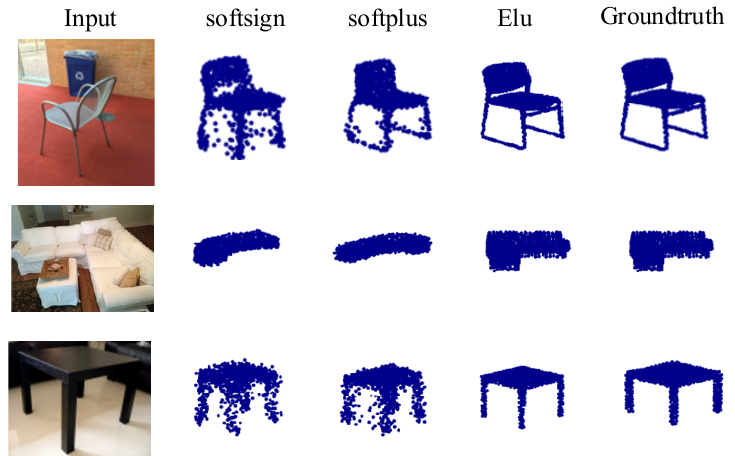
Figure 6. Visualization of 3D-SSRecNet’s predictions with different activation functions on Pix3D.